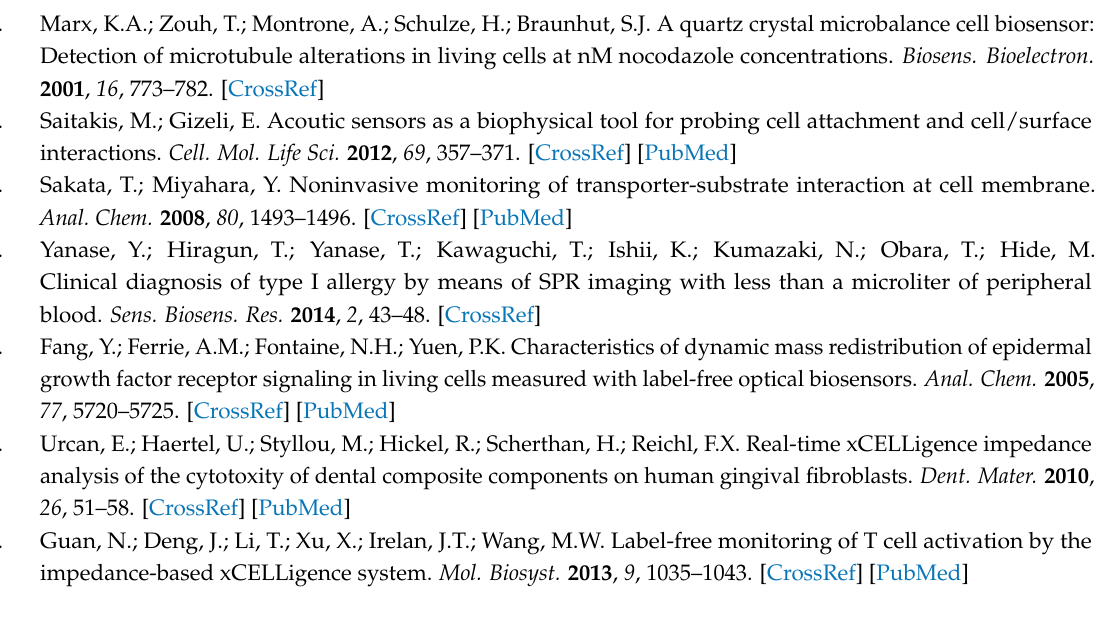
s1. Figure S1, the mechanism of type I allergy. Figure S2, Cl changes ( ∆ Cl) of PAM212 cells in response to EGF. Figure S3, effects of inhibitors on CI of RBL-2H3 cells with or without stimulation by DNP-HSA. The gray-bar indicates the presence of each inhibitor, and the bold black-bar indicates the presence of DNP-HSA. Figure S4, correlation of the amount of QR-specific IgE in sera of patients detected by the cell-based assay using an impedance sensor and ELISA and Figure S5, (a) Cl changes of RBL-48 cells sensitized with serum a non-responder in response to anti-IgE. (b) Histamine release of basophils from a non-responder in response to